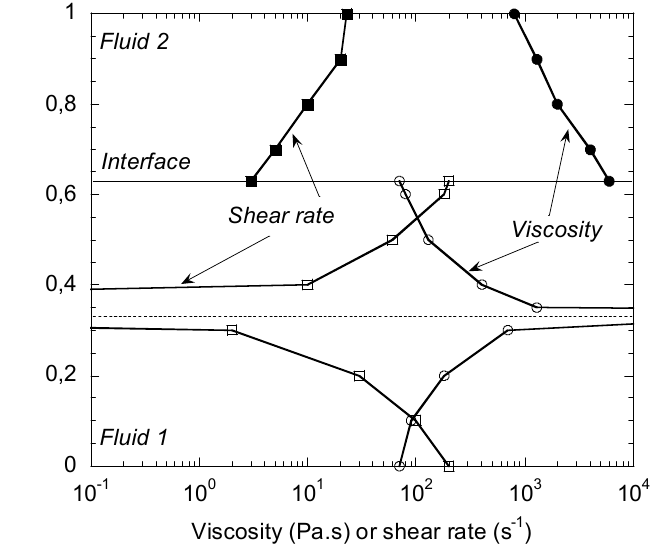
Figure 11. Shear rate ( ■ , □ ) and viscosity ( ● , ○ ) through the gap for the velocity profile (a) of Figure 10 (Reprinted from Ref. [2]).